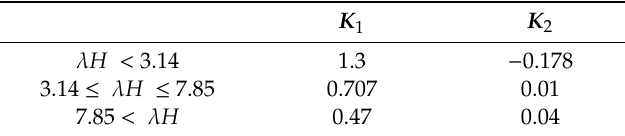
Table 3. Coe ffi cients K 1 and K 2 .